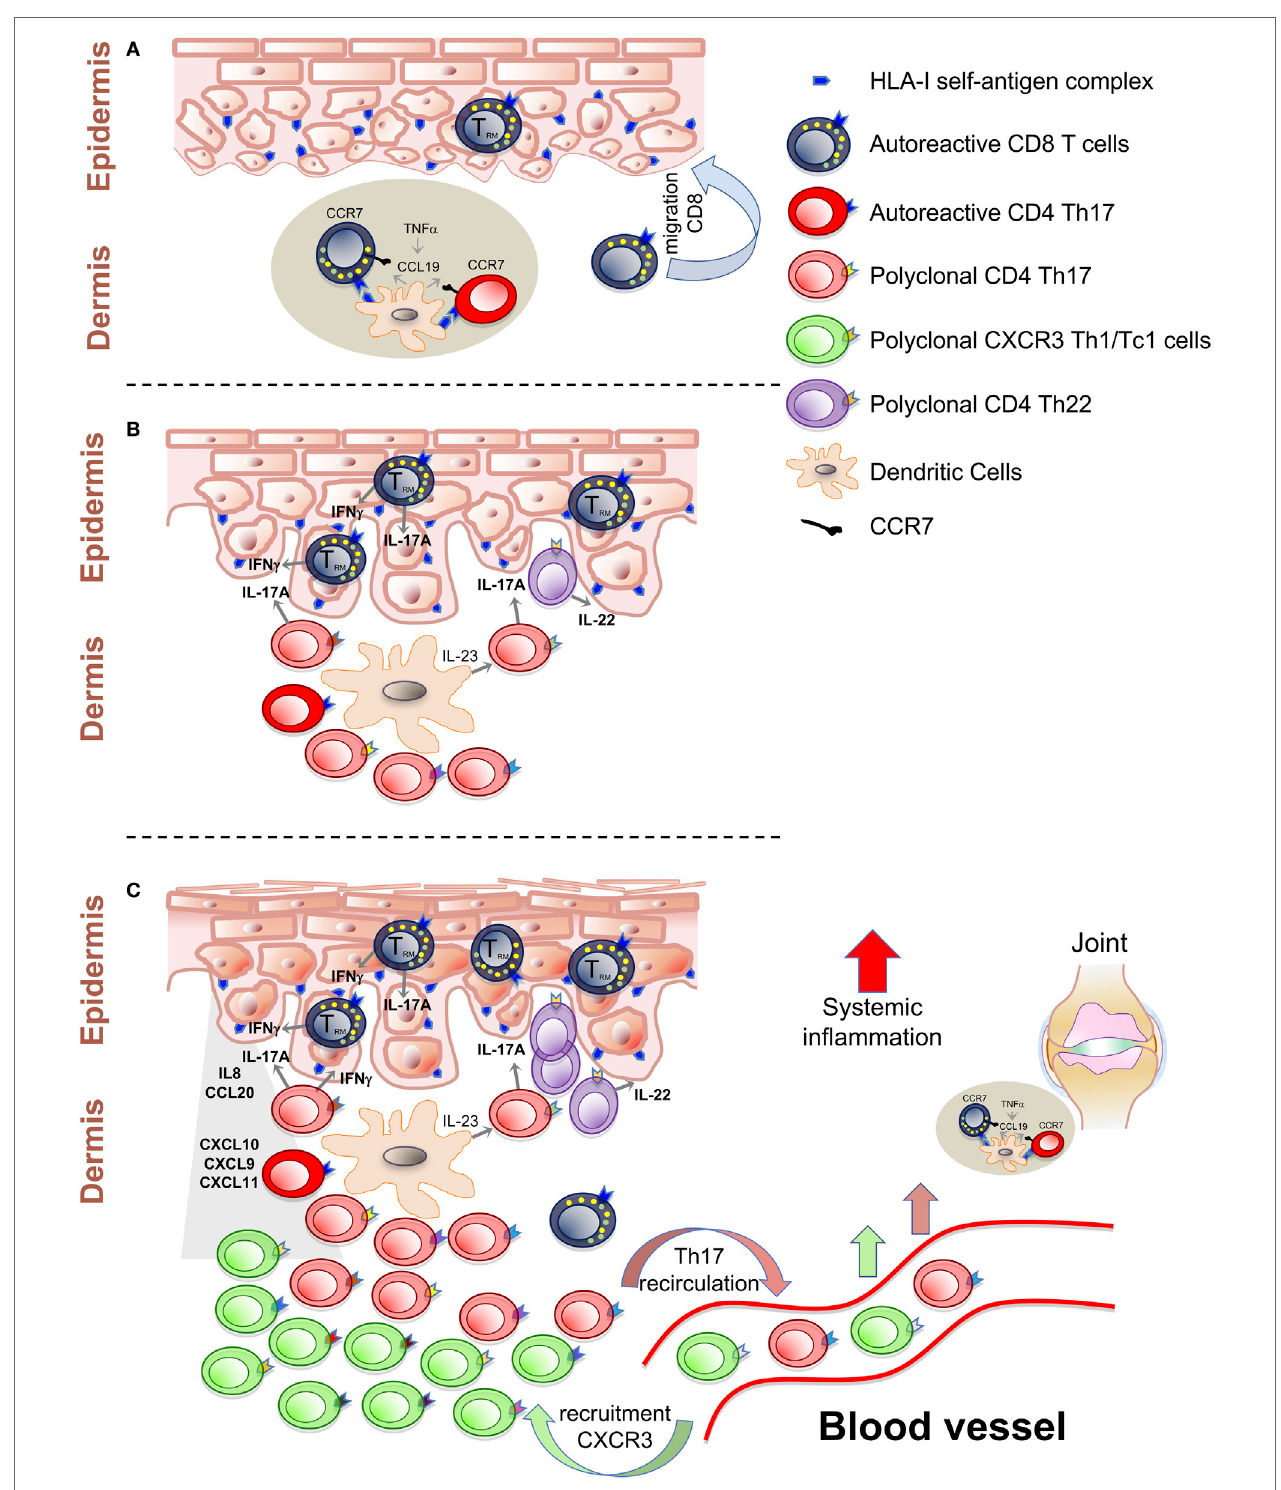
FigURe 1 | T cell-mediated events in the psoriatic inflammatory cascade. (A) Activation of autoreactive T cells by self-antigens presented in the dermal lymphoid aggregates. Establishment of CD8 + T RM cells as central autoimmune component of disease pathogenesis and potential mechanisms of site-specific disease memory. (B) Polyclonal T cells proliferation and Th17/Tc17-mediated inflammation around the IL-23/IL-17A axis. (C) Recruitment of Th1/Tc1 cells, with multiple specificities, from the blood stream, induced by CXCL10 chemokines. Recirculation of T cells from the skin to the blood can spread inflammation at systemic level and at distant